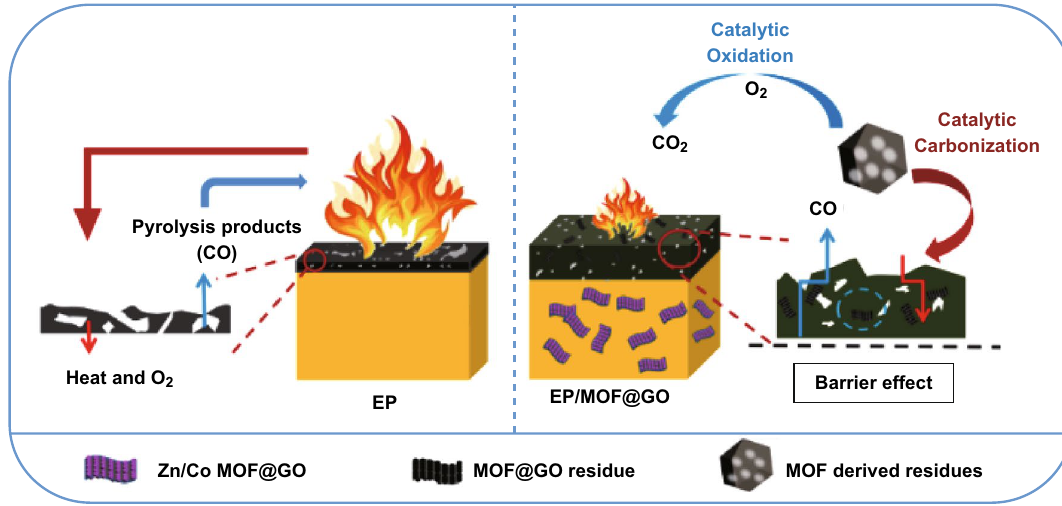
Fig. 15 Proposed fire retardancy mechanism of EP/MOF@GO. Reproduced from Ref. [74] with permission from